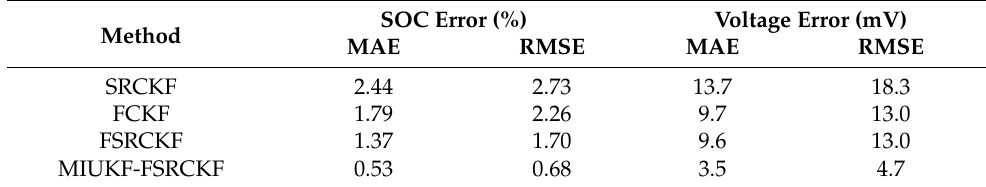
AGA is increased by 20% as the initial value of R 0 increased by 20% as the initial value of R 0 .)